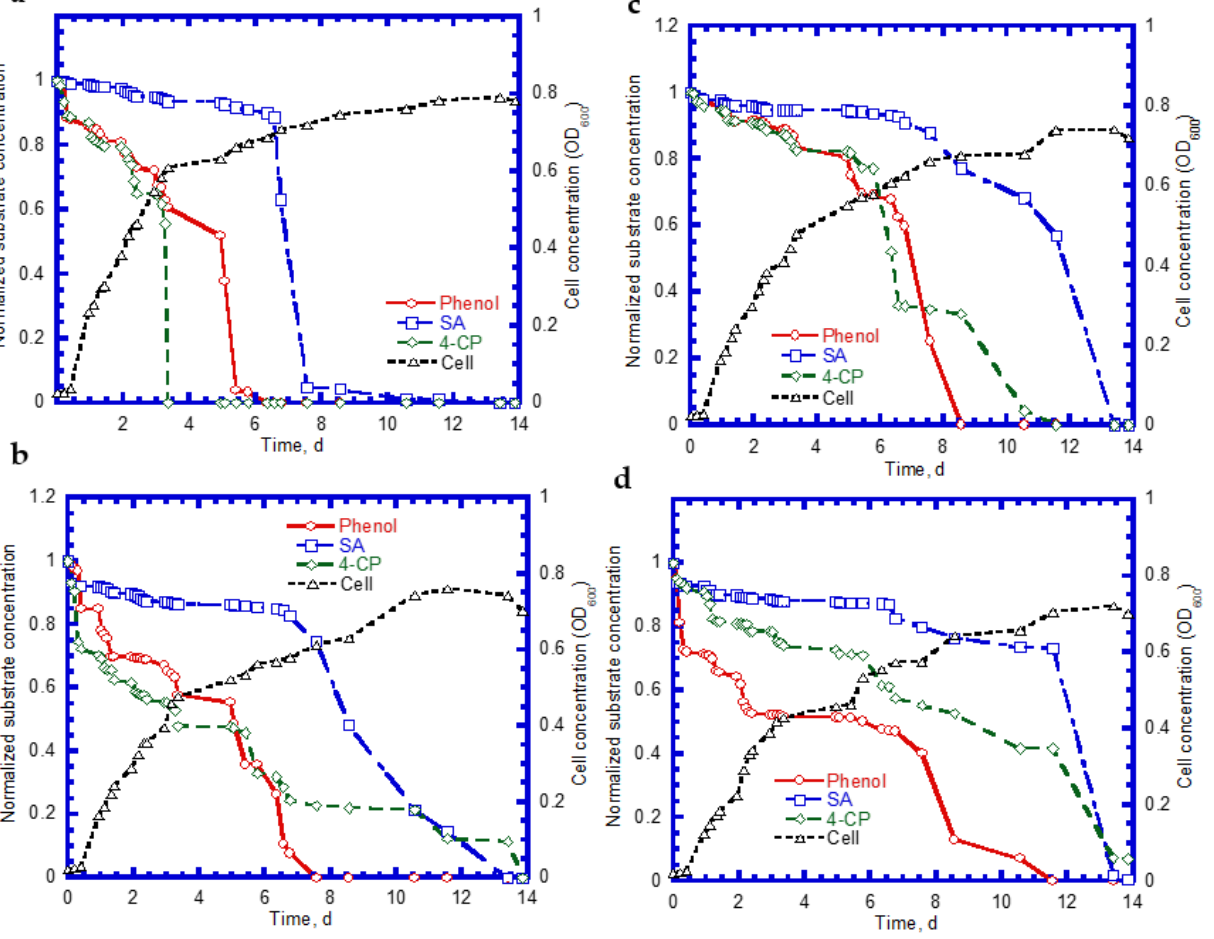
Figure 9. Substrate degradation and cell growth: ( a ) initial [SA] = 238 mg/L, [phenol] = 124 mg/L, and [4-CP] = 14 mg/L; ( b ) initial [SA] = 251 mg/L, [phenol] = 128 mg/L, [4-CP] = 50 mg/L; ( c ) initial [SA] = 229 mg/L, [phenol] = 131 mg/L, and [4-CP] = 83 mg/L; and ( d ) the initial [SA] = 252 mg/L, [phenol] = 175 mg/L, and [4-CP] = 138